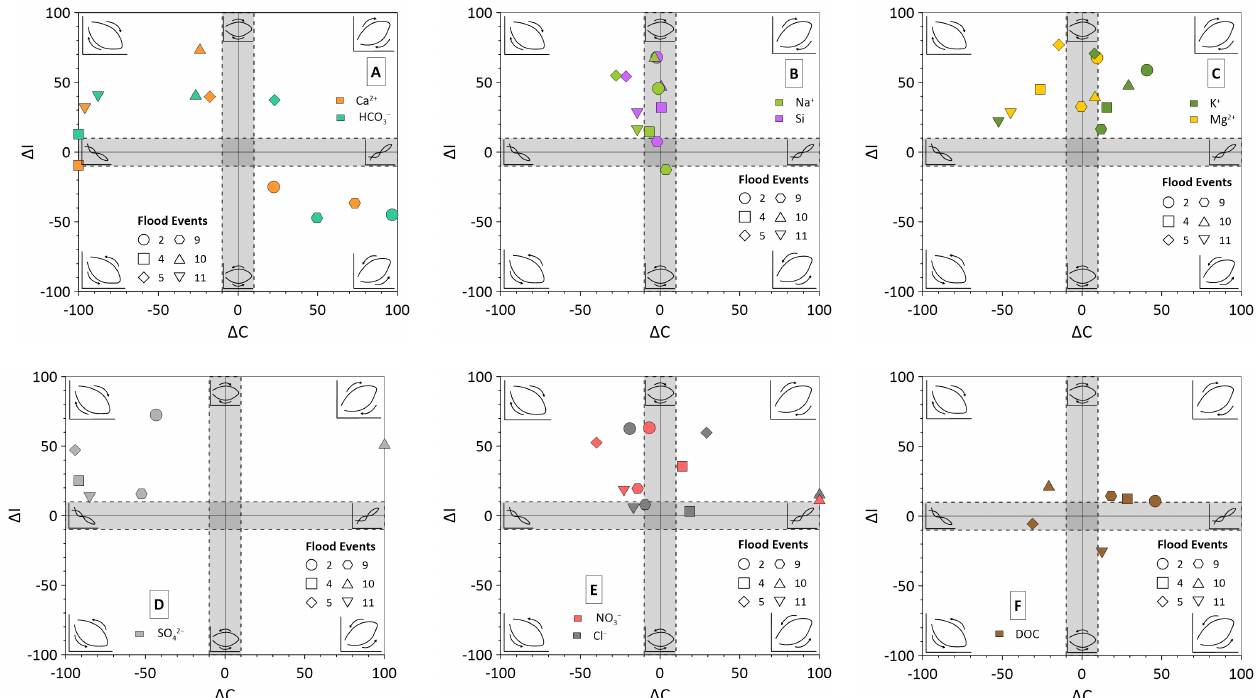
Figure 8. Characterization of the hysteresis loops using the relationships between ∆ I and ∆ C for the different dissolved elements and during the flood events 2, 4, 5, 9, 10, and 11: ( A ) for Ca 2+ and HCO 3 − , ( B ) Si and Na + , ( C ) Mg 2+ and K + , ( D ) SO 42 − , ( E ) Cl − and NO 3 − and, ( F ) DOC. The dotted lines split the plane into nine discrete different types of the C-Q response, represented by a small graphical representation of the C-Q relationship. The grey areas represent ± 10% along the axes.